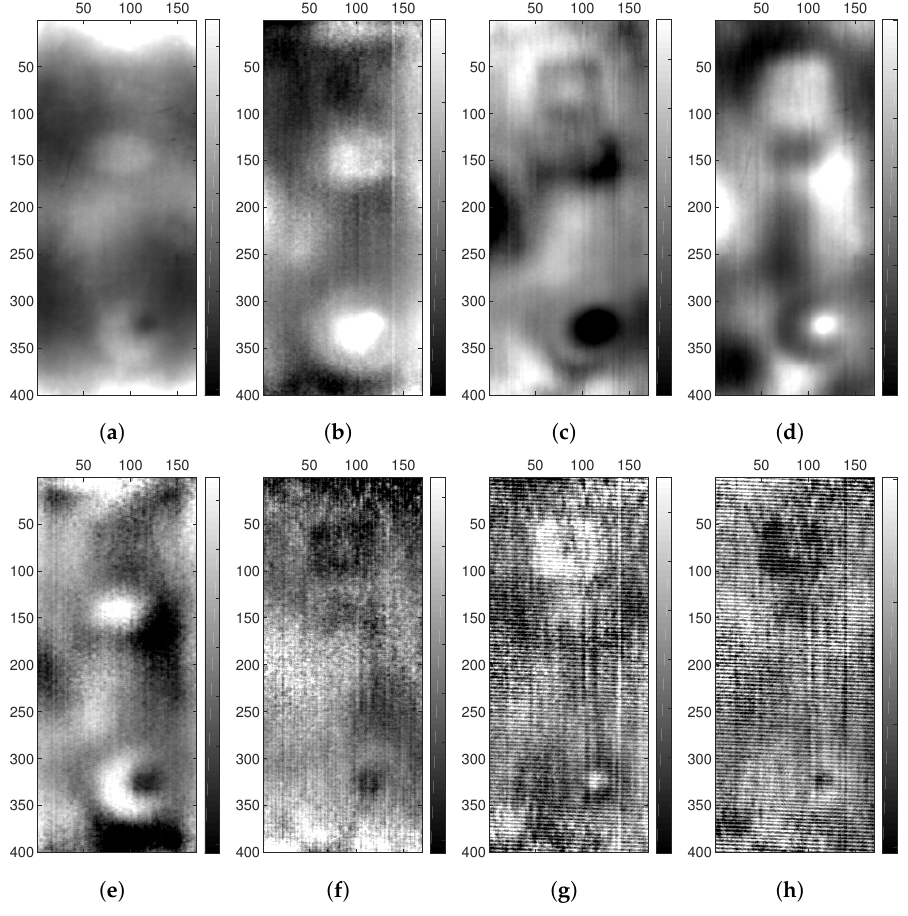
Figure 9. PCT analysis; experiment 2. ( a ) EOF2. ( b ) EOF3. ( c ) EOF3. ( d ) EOF3. ( e ) EOF4. ( f ) EOF7. ( g ) EOF8. ( h ) EOF9. Heating up period for ( a – h ): 10, 10, 25, 40, 10, 25, and 40 s, respectively. For a better understanding of the influence of different types of cavities in the IRT results, the temperature graphs (Figure 11) of the relevant regions were studied. The nondefective regions have the lowest temperature value during the cooling down phase. The second lowest temperature belongs to zone 2, above cavity 2 (thin air); as indicated